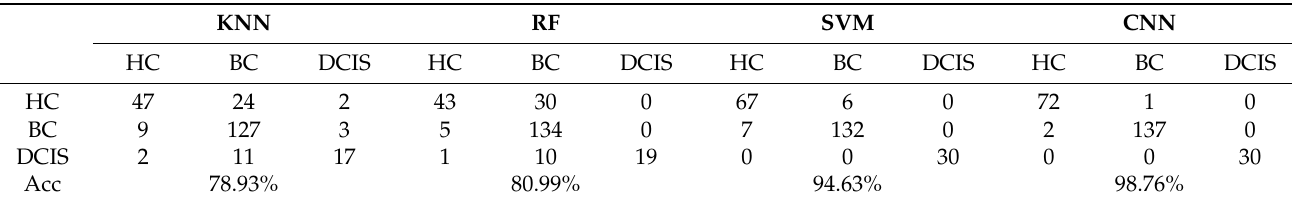
Table 4. Confusion matrix for the KNN, RF, SVM and CNN